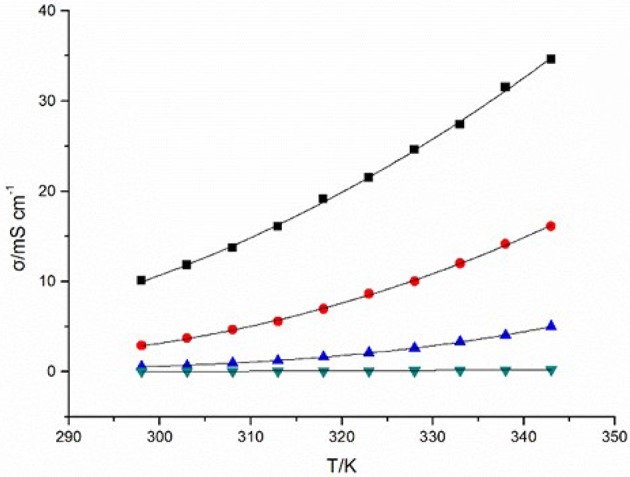
Conductivities (σ) of [C4mim][N(CN)2] (black), [C4m2im][N(CN)2] (red), N4442[N(CN)2] (blue), and N8444[N(CN)2] (green) at different temperatures.